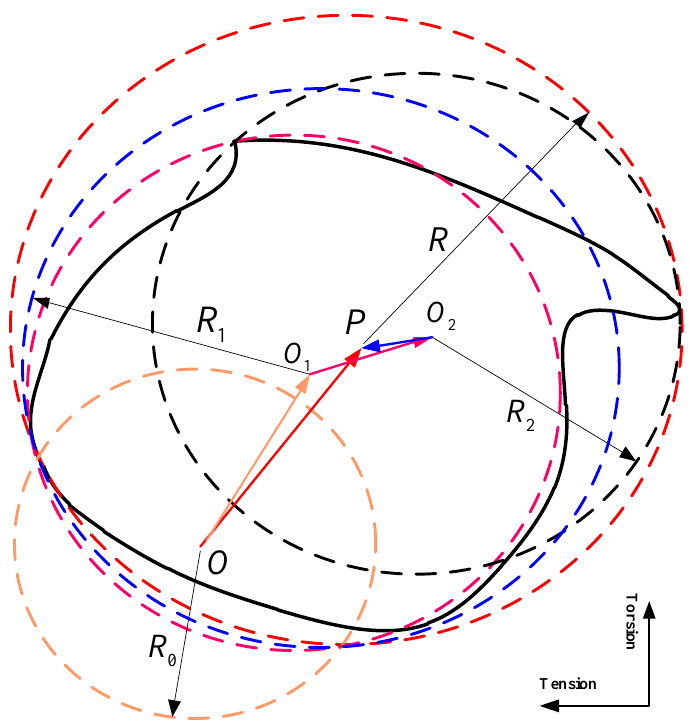
Figure 1. Calculation of the residual stress tensor and elastic shakedown limit.